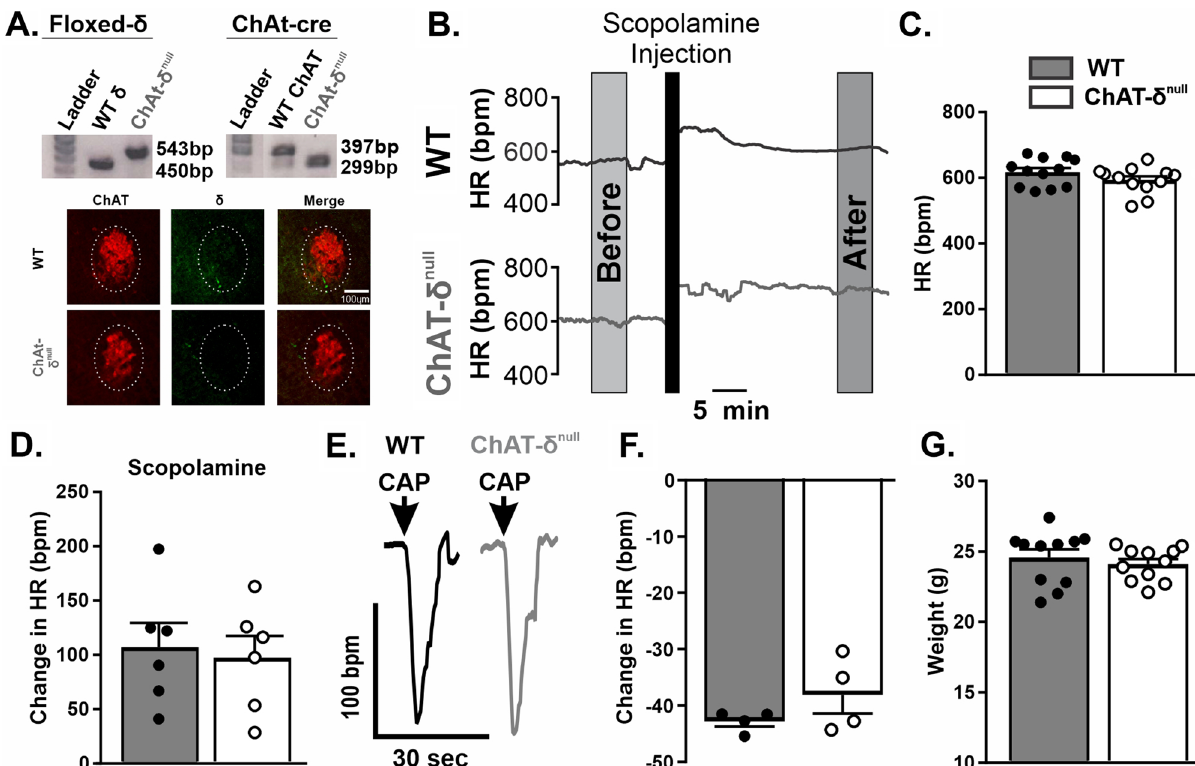
Figure 4. Novel ChAT-δ null mice strain showed no differences in resting HR and reflex responses compares to C57/BL6 wild-types (WTs). ChAT-δ null transgenic mice were generated by cross breeding floxed Gabrd and ChAT cre mouse lines. Genotyping with in-house PCR confirmed that mice classified as ChAT-δ null were homozygous for both gene cassettes. Qualitative immunohistochemical imaging confirmed that ChAT-δ null had reduced GABA A (δ)R protein expression compared to WT mice in the NA ( A ). Original PCR gel is presented in Supplementary Fig. 2. Knock down of GABA A (δ)R was confirmed using PCR and immunohistochemistry ( A ). Representative traces ( B ) and mean HR ( C ) in awake WTs (n = 12) and ChAT-δ null mice (n = 12) showed no differences between groups. Change in HR in response to methylscopolamine was not different between strains (WT: n = 6; ChAT-δ null : n = 6) ( D ). Representative traces ( E ) and mean HR responses ( F ) to capsaicin in WT (n = 4) and ChAT-δ null mice (n = 4) show no differences between groups. Both mouse strains show similar weight on NFD (WT: n = 12; ChAT-δ null : n = 12) ( G NFD (132 ± 23 bpm; n = 7; unpaired Students t-test, p = 0.60; Fig. 5G). An examination of the relative contribu- tion of each branch of the autonomic nervous system (PNS and SNS) revealed no significant difference between HFD or NFD in either PNS or SNS (diet X autonomic branch interaction: p = 0.42; repeated measure two-way ANOVA; Fig. 5H). Finally, intrinsic HR was not different between animals fed HFD (571 ± 6 bpm; n = 7) or NFD (561 ± 6 bpm; n = 7; unpaired Student t-test; p = 0.27; Fig. 5I). Taken together, genetic deletion of GABA A (δ)Rs from ChAT + neurons ameliorated the blunting of vagal reflex responses, increase in resting HR, and decreased vagal tone that accompanied HFD feeding in mice.